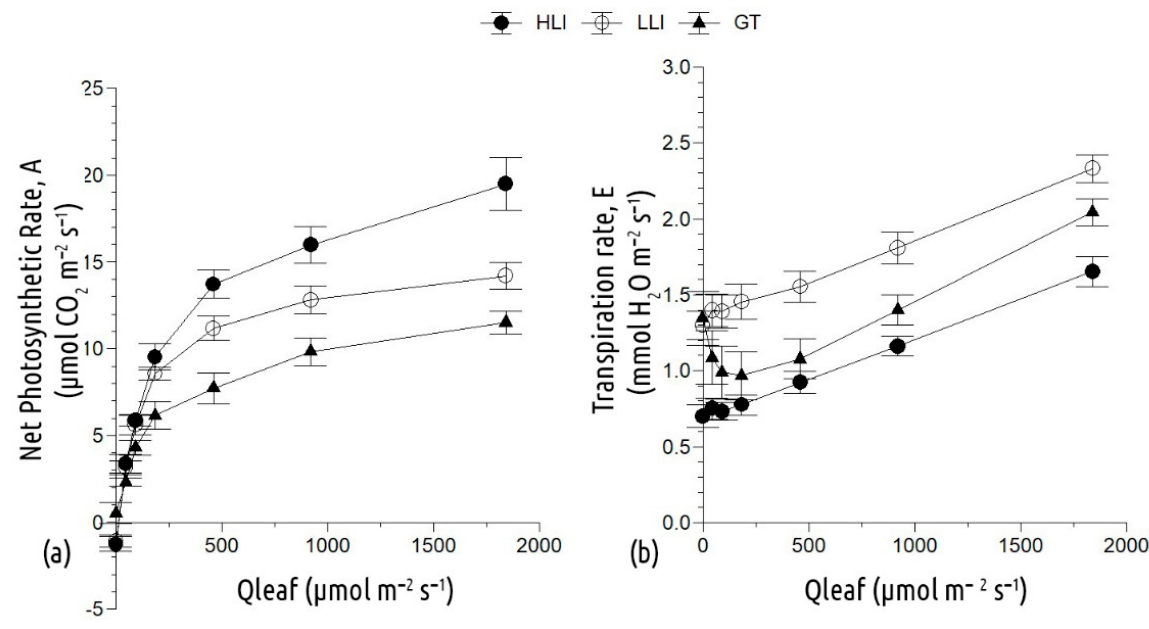
Figure 5. Net Photosynthetic Rate, A, ( a ), Transpiration rate, E, ( b ) of an average lettuce grown under each treatment’s conditions. HLI, High light intensity; LLI, Low light intensity; GT, Glasshouse treatment. Vertical bars indicate ± standard errors of means.